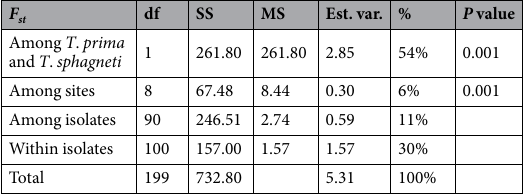
Table 2. Hierarchical AMOVA across 10 SSR loci with six of 10 loci set to a fixed difference for Tulasnella sphagneti .